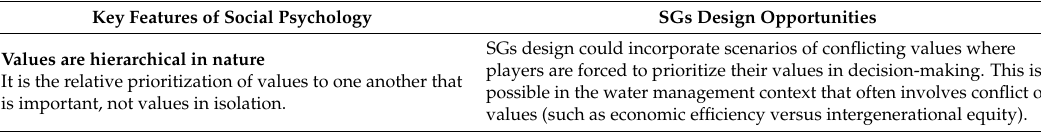
Table 2. Serious games (SGs) design opportunities for “learning” transcendental